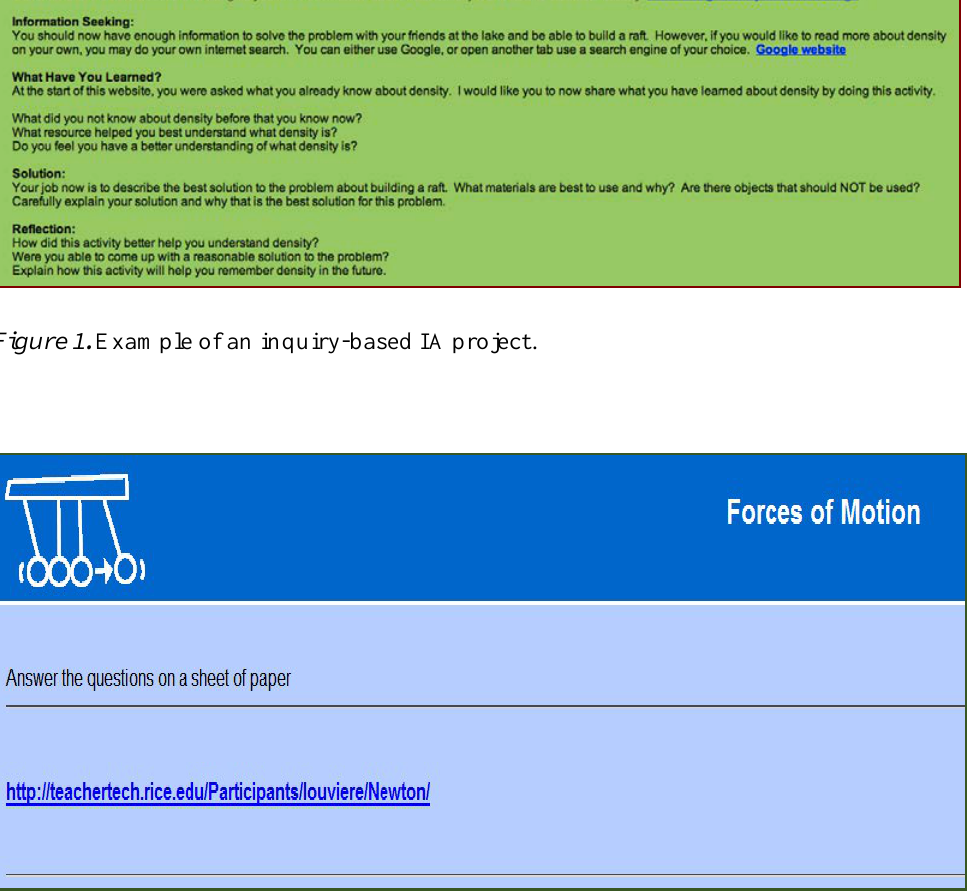
Figure 2. Example of an IA project with minimal text and a link to one